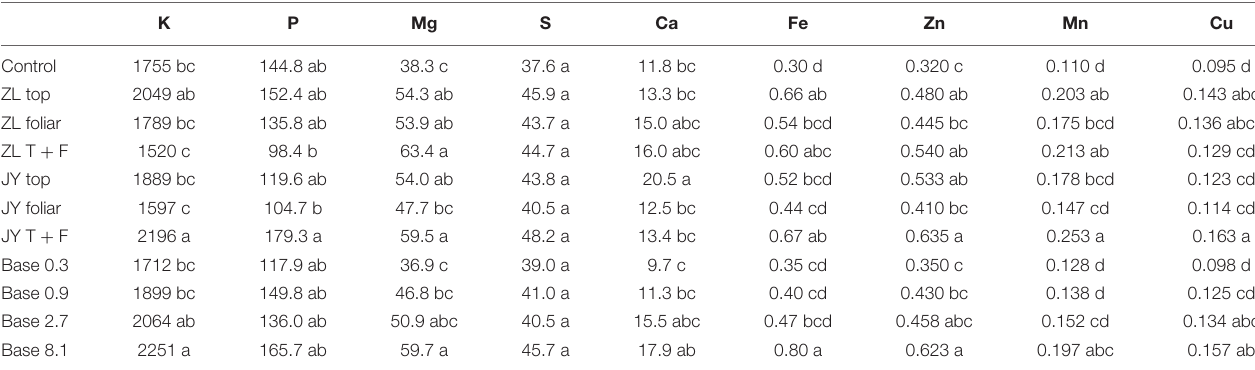
TABLE 5 | The effect of fulvic acids on mineral concentration ( µ g g − 1 ) in fruit juices of tomato plants cv. Hezuo906 grown in the soil culture for 126 days from transplanting (Experiment